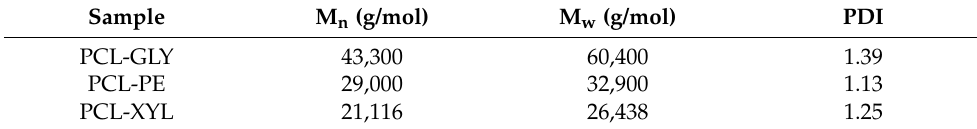
Table 1. Molecular weights, PDI, and intrinsic viscosities of the synthesized PCL-copolymers. Sample M n (g/mol) M w (g/mol) PDI PCL-GLY 43,300 60,400 1.39 PCL-PE 29,000 32,900 1.13 PCL-XYL 21,116 26,438